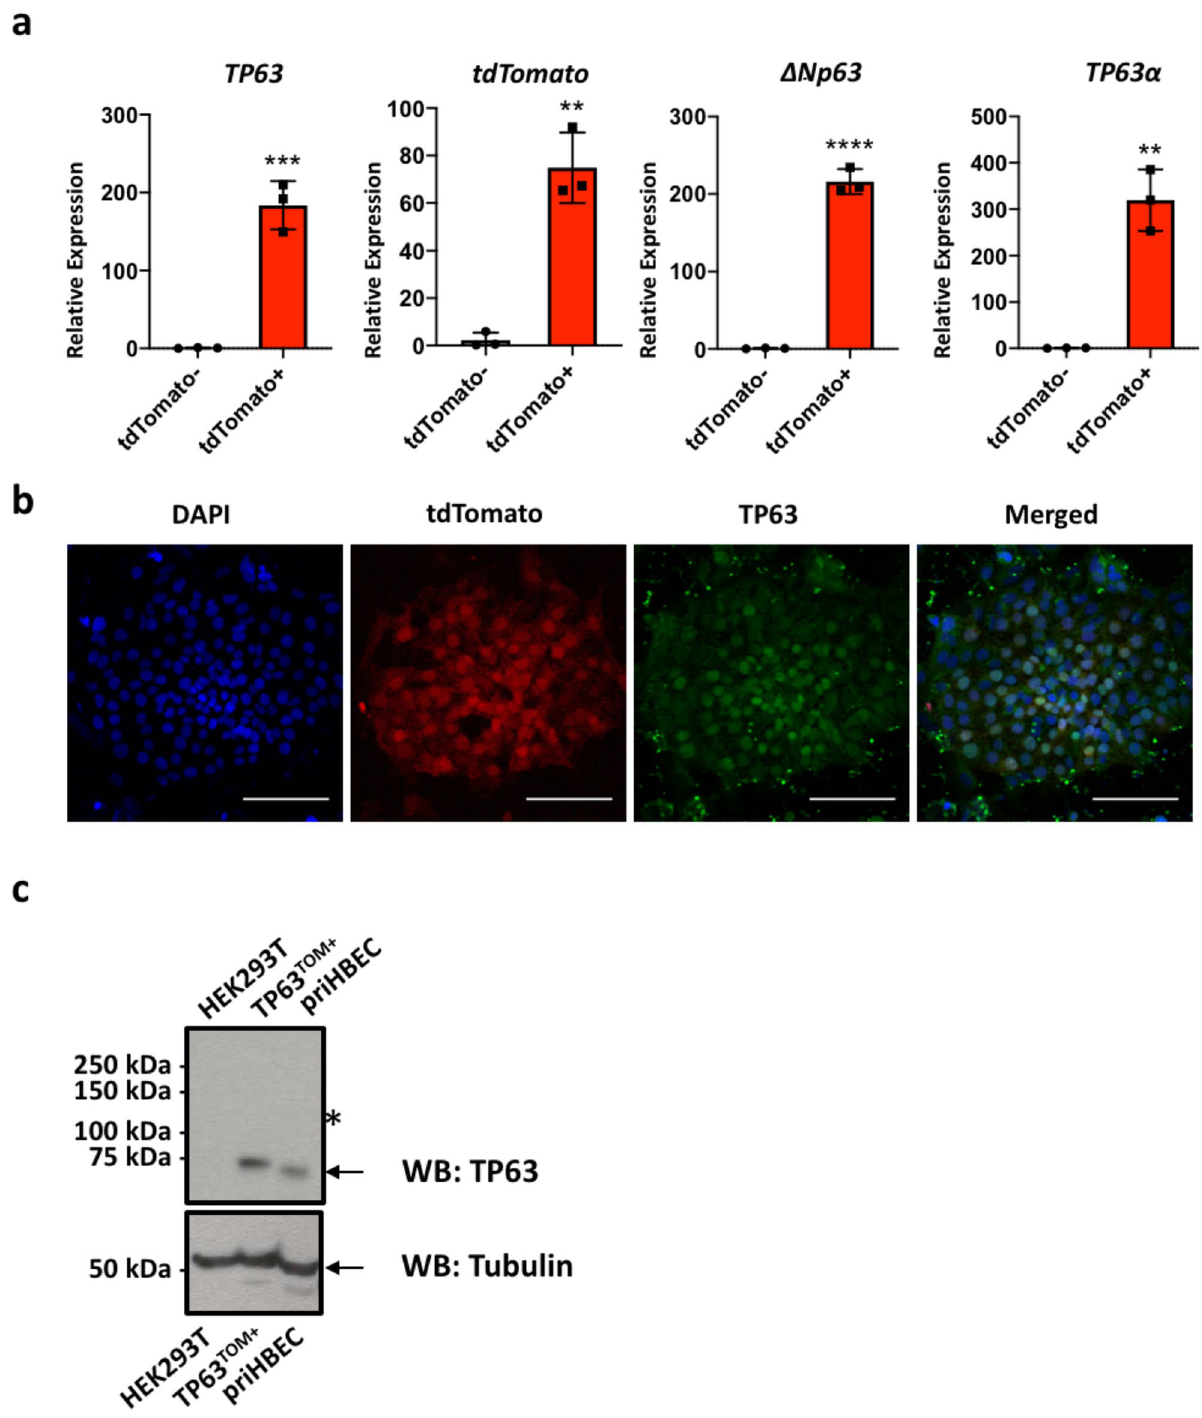
Figure 3. Assessment of tdTomato reporter specificity. ( a ) QPCR analysis of TP63 (total), ∆ Np63 , TP63α and tdTomato expression in tdTomato- and tdTomato + fractions. n = 3. **p < 0.01, ***p < 0.001, ****p < 0.0001. t test. Graphs were made and statistical analyses were done using GraphPad Prism 8.0 (GraphPad Software Inc., San Diego, CA, USA) (www.graph pad.com). ( b ) Isolated tdTomato + cells plated onto Matrigel-coated plates and immunostained for TP63. Scale bar indicates 100 µm. ( c ) Western blot analysis of TP63 and Tubulin. 30 µg of whole cell lysates prepared from HEK293T cells overexpressing tdTomato (HEK293T), TP63TOM + cells, and primary human bronchial epithelial cells (priHBEC). Blots were probed with anti-TP63 antibody with Tubulin used as a loading control. Bands corresponding to TP63 and Tubulin are indicated by black arrows. The asterisk indicates where the uncleaved TP63-P2A-tdTomato protein of about 110 kDa is expected to be, if present. The full uncropped blots are presented in Supplementary Fig.